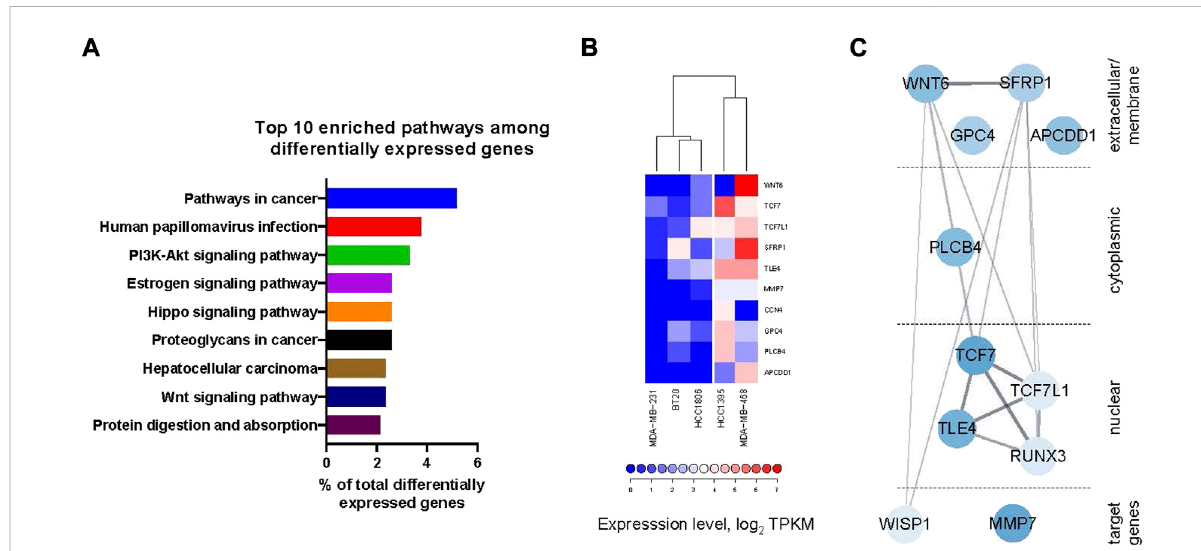
FIGURE 6 (A) Top 10 enriched pathways (by DAVID online tool) among the genes differentially expressed between the lines highly sensitive to the compound treatment (HCC1395 and MDA-MB-468) and those with poor sensitivity (HCC 1806, BT20 and MDA-MB-231) (see also Supplementary Table S3) includes Wnt-pathway. (B) Heatmap of the expression levels of differentially expressed Wnt-pathway component and target genes with clustering clearly delineates the cell lines sensitive to the compound treatment. (C) Representation of the differentially expressed Wnt-related genes as a network with physical and genetic interactions overlaid from StringDB. Intensity of coloration is proportional to the overall difference in the expression levels between the sensitive and insensitive